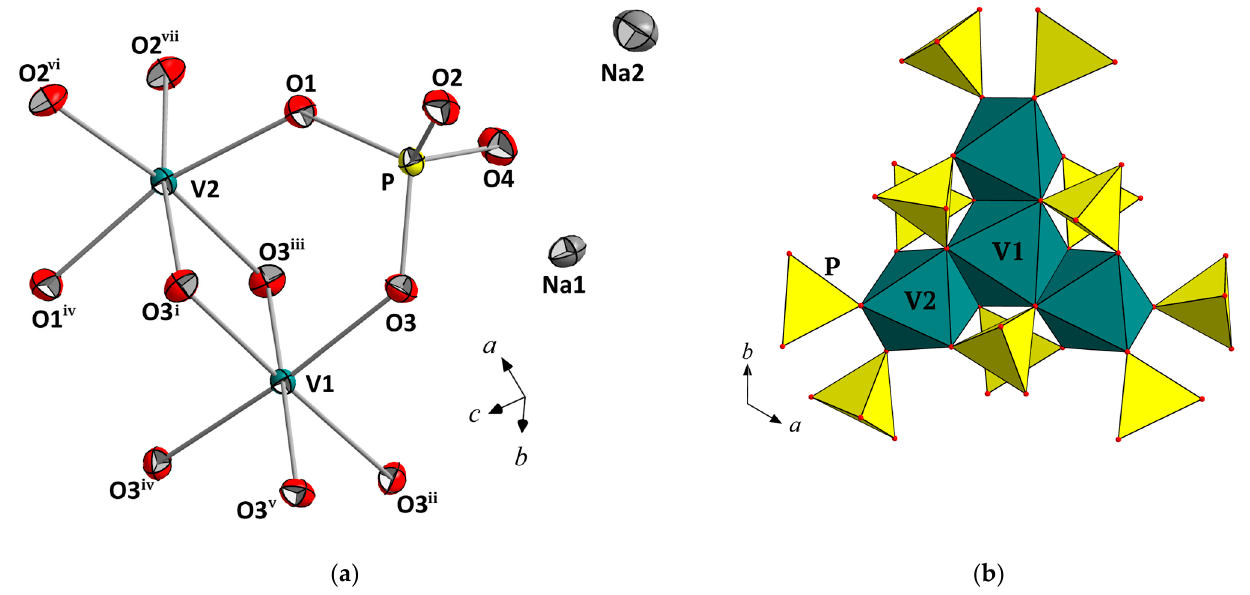
Table 2. Selected distances (Å).